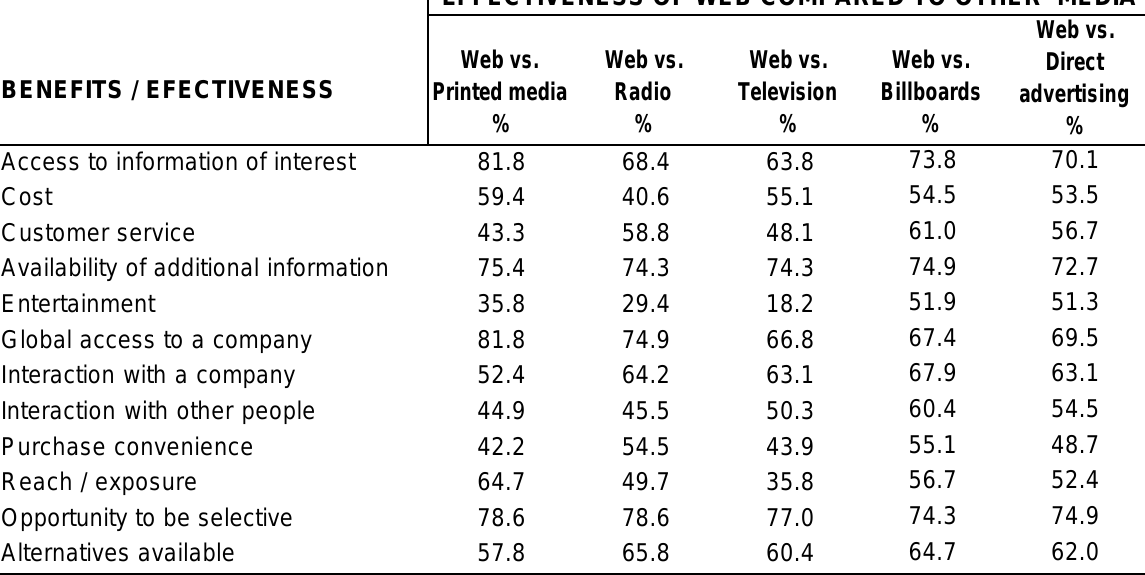
TABLE 9: THE EFFECTIVENESS OF THE WEB COMPARED TO DIFFERENT MEDIA EFFECTIVENESS OF WEB COMPARED TO OTHER MEDIA Web BENEFITS / EFECTIVENESS